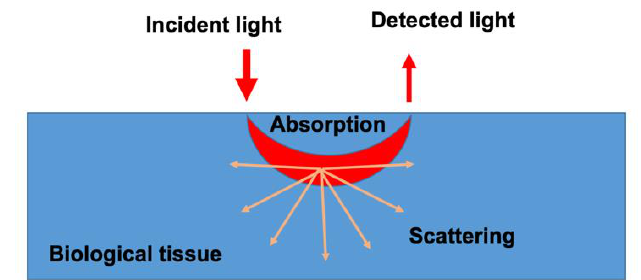
Figure 1. Illustration of the light signal propagation via a biological tissue after it has been partially absorbed and scattered.